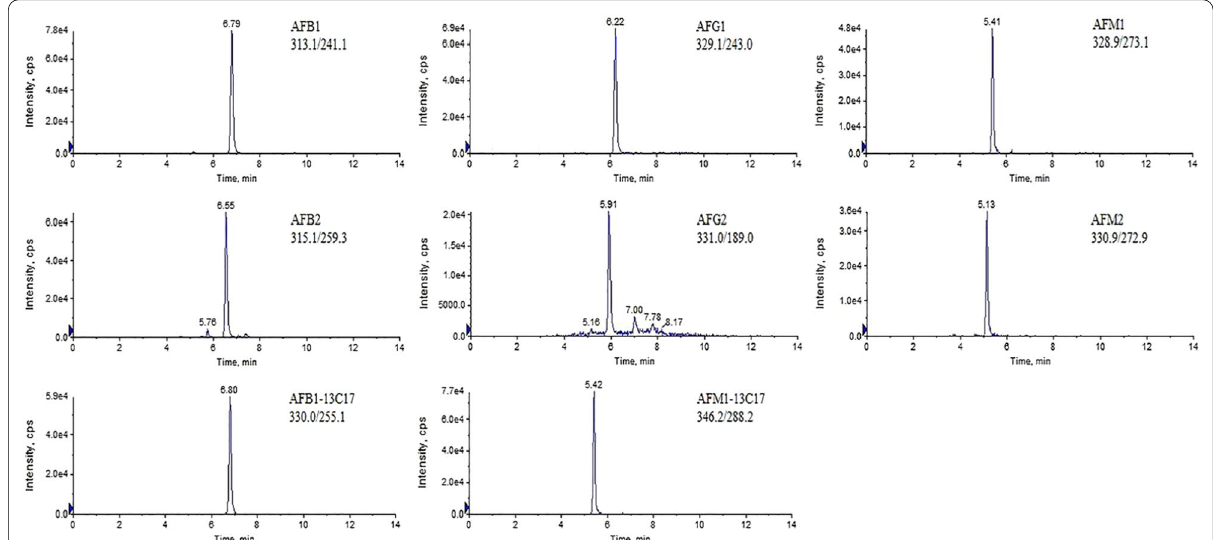
Fig. 4 MRM chromatograms of quantitative ions for aflatoxins ( spiked at 0.5 ng/mL) and IS (AFB1- 13 C 17 spiked at 0.3 ng/mL and AFM1- 13 C 17 spiked at 0.9 ng/mL)